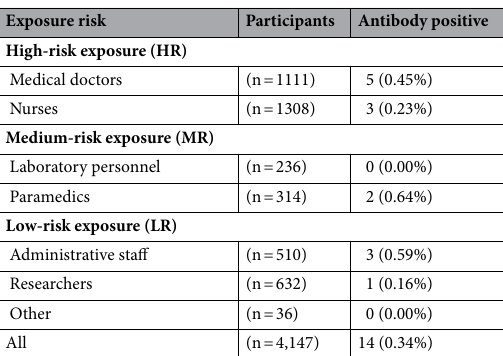
Table 2. Antibody seroprevalence among healthcare workers according to the risk of exposure and professional category. Data are presented as n or n (%).